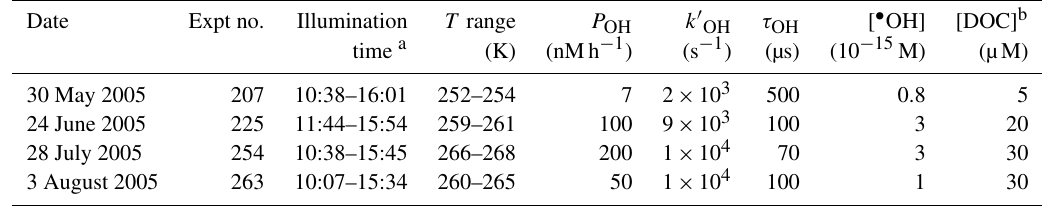
Table 1. Summary of snow samples studied in the field at Summit, Greenland.